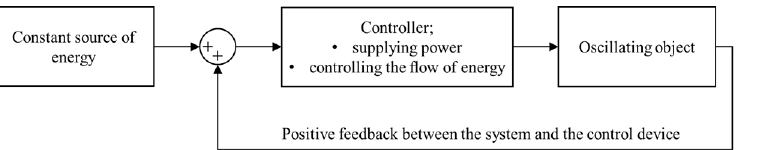
Figure 1. Diagram of a self-excited system.